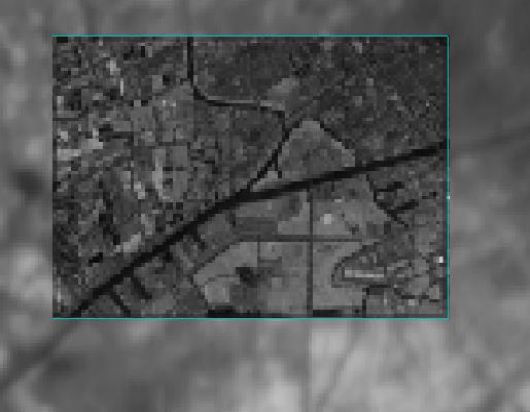
Figure 6. Without RPC correction of August 14